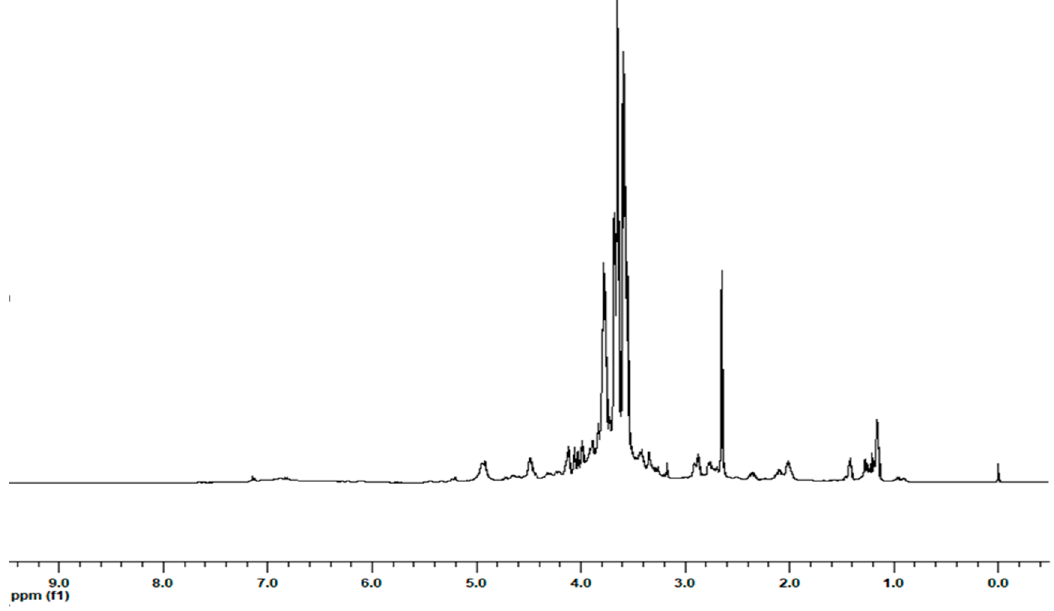
Figure 1. Representative 1D NMR spectrum of LDC3.